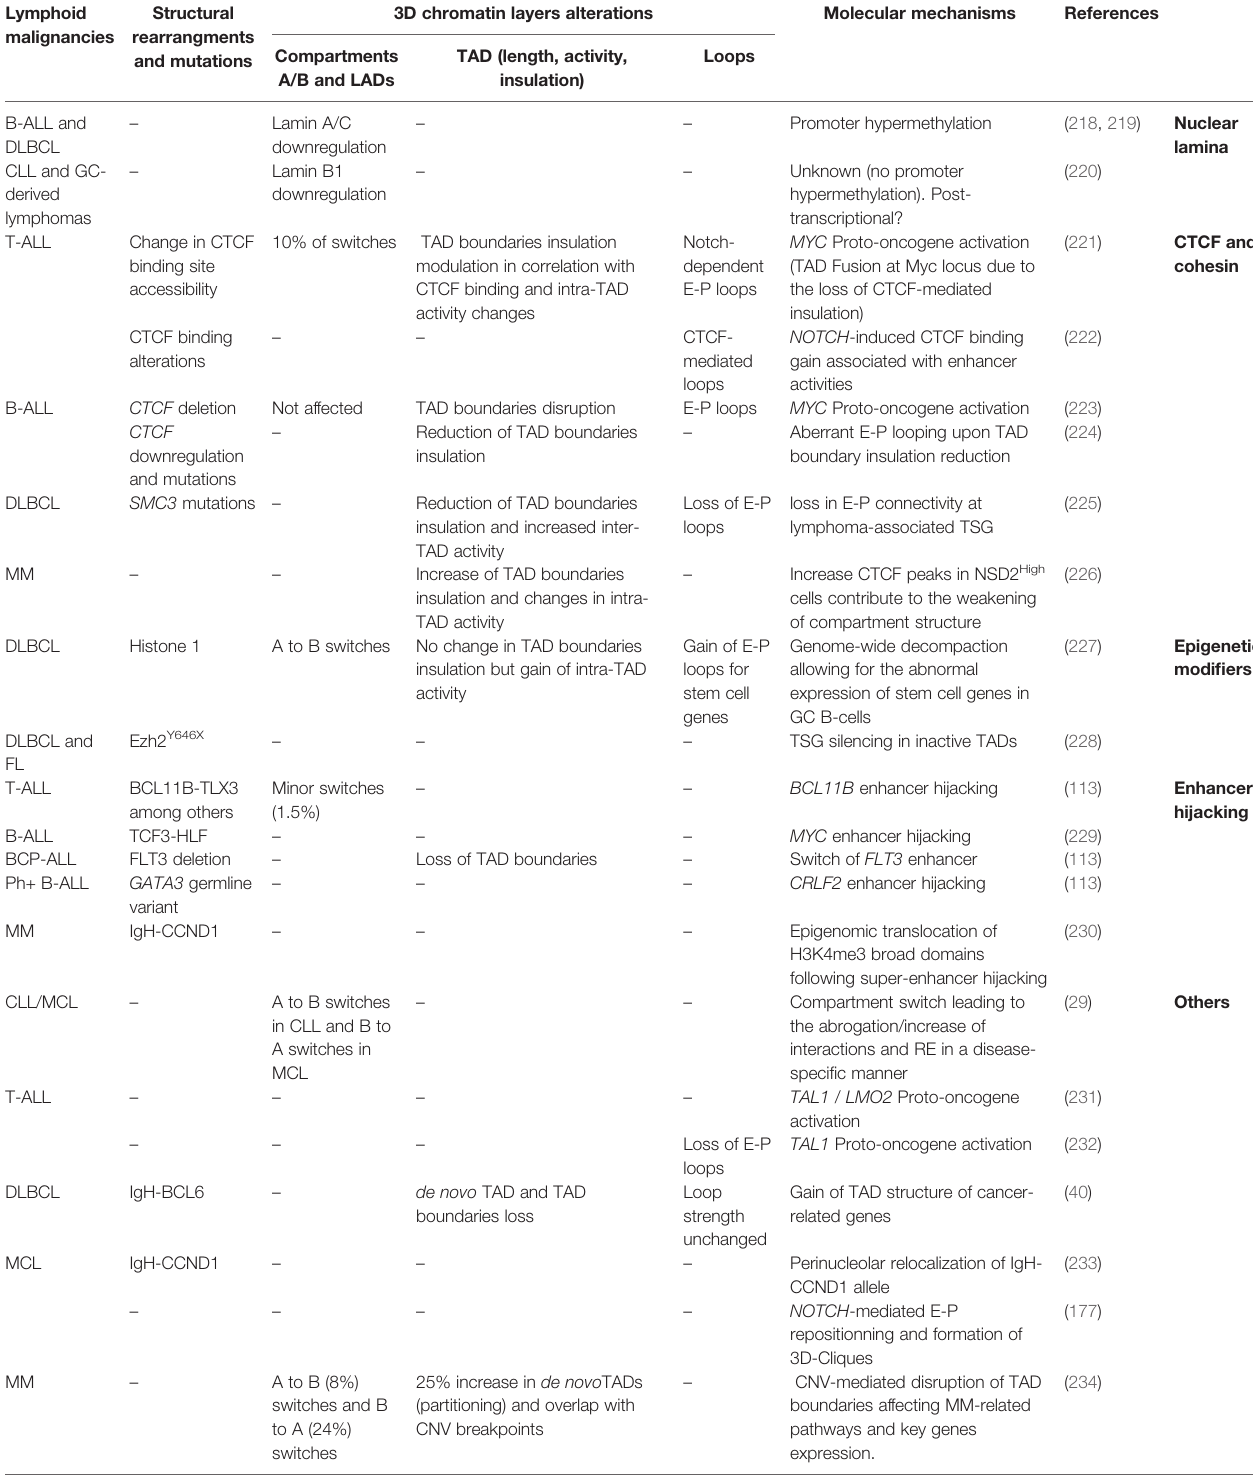
TABLE 1 | Overview of 3D chromatin alterations in lymphoid